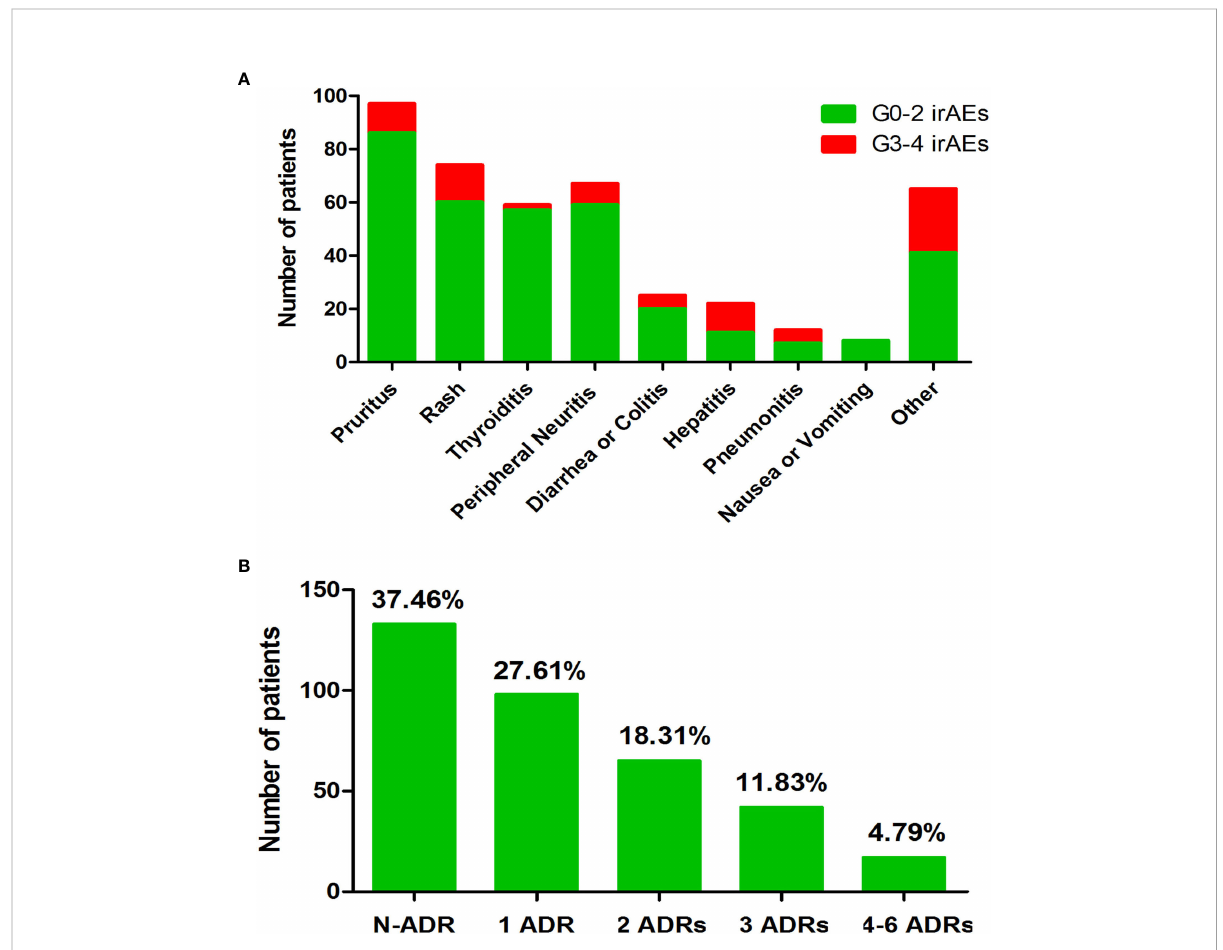
FIGURE 1 Overview of the irAEs that occurred during follow-up. (A) Number of patients of each type of irAE. (B) Number of irAEs that occurred during follow-up time. Note. N-ADR, number of patients without adverse drug response (ADR); 1 ADR, number of patients with one kind of ADR; 2 ADR, number of patients with two kinds of ADR; 3 ADR, number of patients with three kinds of ADR; 4 – 6 ADR, number of patients with four to six kinds of ADR; irAEs, immune-related adverse